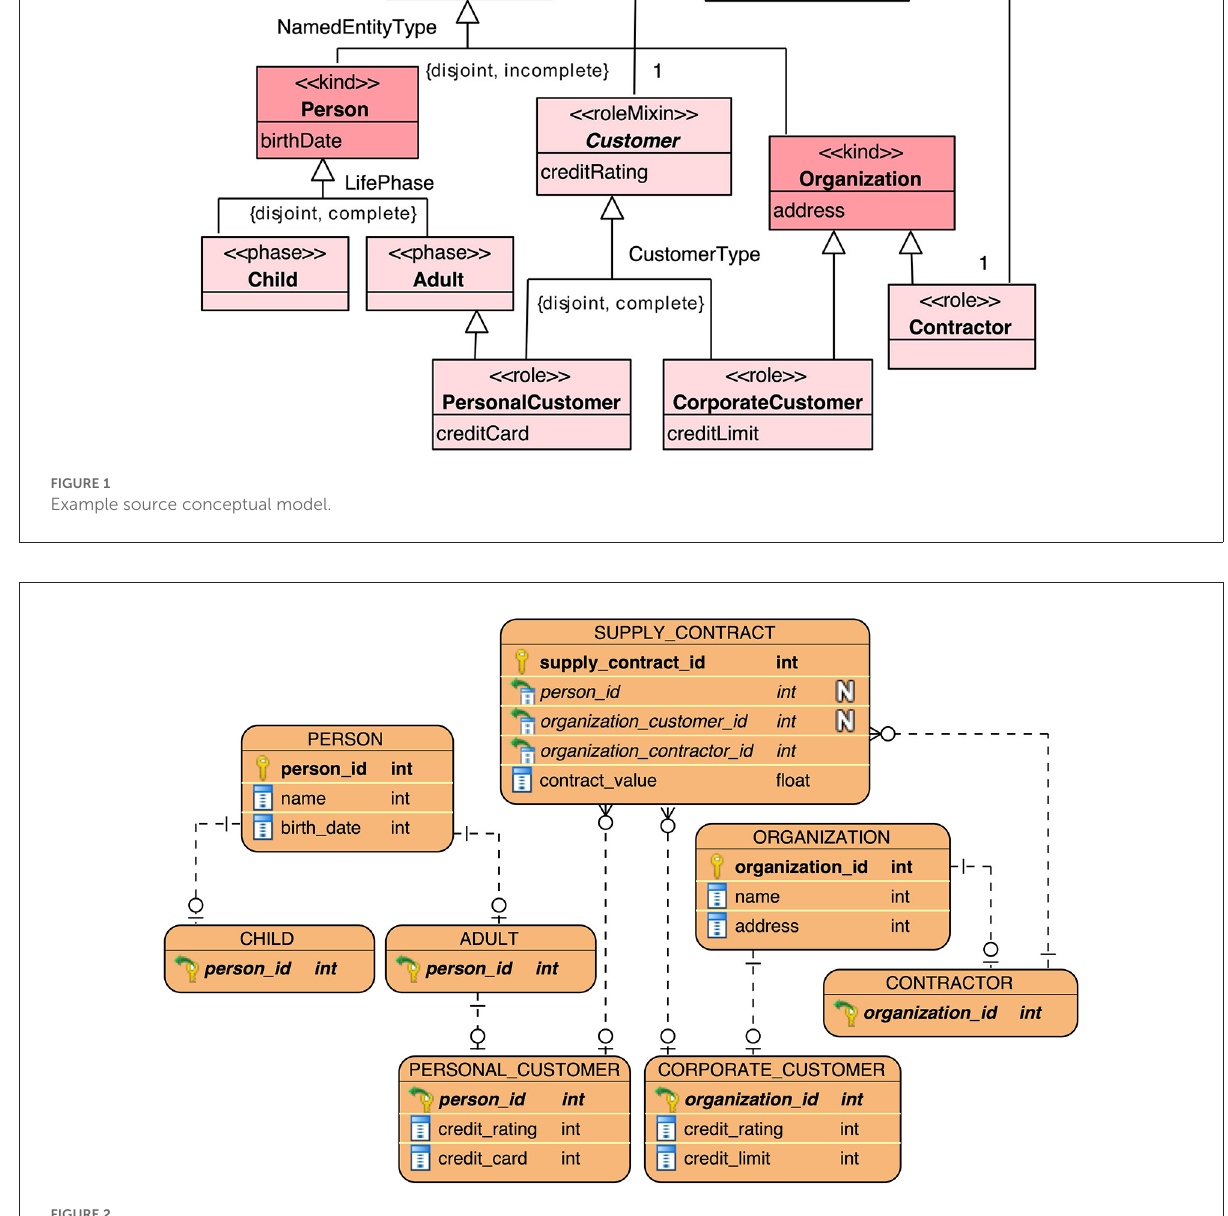
FIGURE2 Target schema with the one table per concrete class